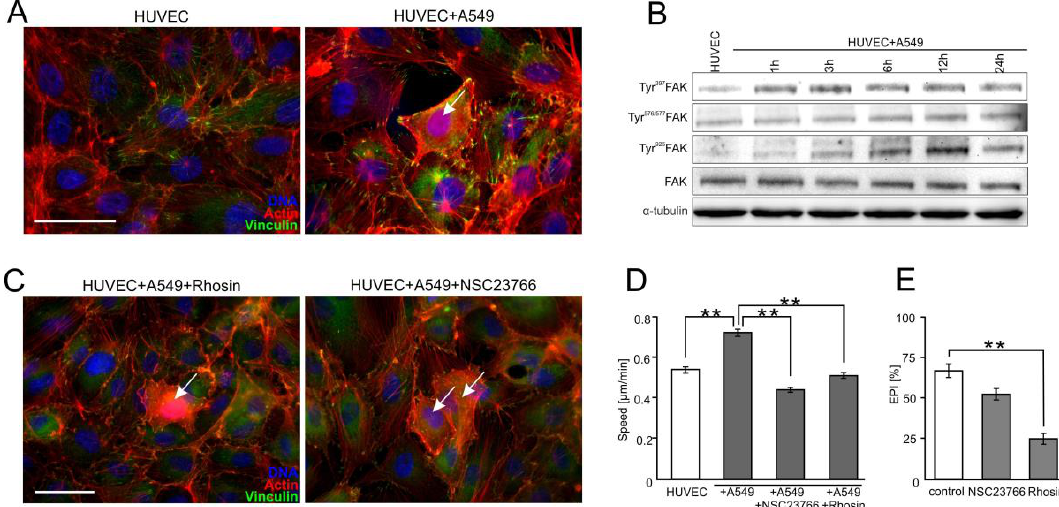
Figure 4. Focal adhesion kinase ( FAK)/RhoA-dependent signaling participates in the activation of HUVECs by A549 cells. ( A ) A549 cells (marked with arrow) were seeded onto the monolayer of HUVEC as described in Figure 1, cultivated for 6 h, fixed, and stained for F-actin and vinculin. ( B ) A549/HUVEC co-cultures were established as above, and Tyr 397 , Tyr 576/577 , and Tyr 925 FAK were analyzed at the indicated time points by immunoblotting and quantified by densitometry (Figure S5D). ( C ) Cytoskeletal architecture of HUVEC cultured in co-cultures with A549 cells treated with Rhosin (left) or NSC23766 for 6 h (right). ( D , E ) A549/HUVEC co-cultures were treated with Rhosin and NSC23766 followed by the analyses of HUVEC motility ( D ) and A549 diapedesis ( E ; 6 h). Error bars represent SEM. The statistical significance of the differences was tested with one-way ANOVA followed by post-hoc Tukey’s HSD ( D , E ); ** p < 0.01. All results are representative of at least three independent experiments ( n ≥ 3). Scale bar = 40 μm. Note that RhoA/Rac1-dependent disruption of endothelial continuum by A549 cells is accompanied by FAK activation and cytoskeletal rearrangements in proximal HUVECs.